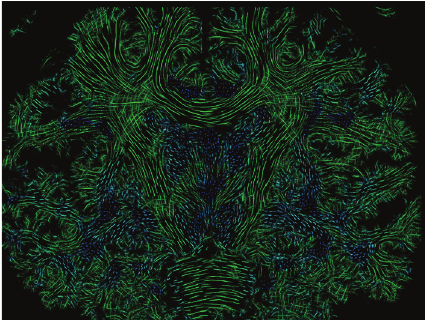
Figure 14: Coronal view of a color-coded slice of healthy